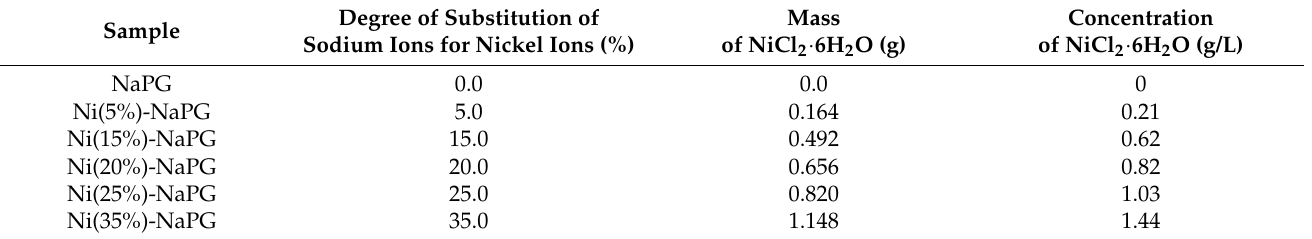
Table 2. Samples of the synthesized coordination polymers, the degree of substitution of sodium ions for nickel ions, the mass of the initial salt per 400 mL of sodium pectate